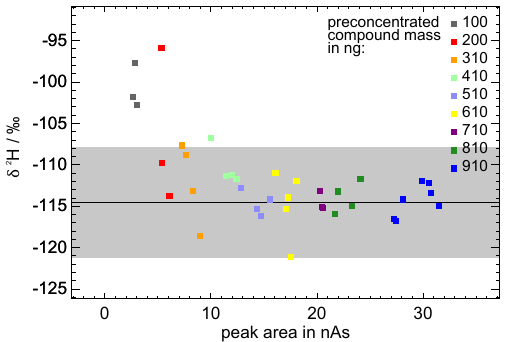
Figure 5. A step in δ 2 H values was apparent after 6 measurements, when the ceramic tube was conditioned for 5min, after 10 measure- ments, when conditioned for 10min, and after 20 measurements, when conditioned for 20min. The measurements after conditioning for 5min are represented by red dots, measurements after condition- ing for 10min by blue triangles and measurements after 20min by green squares. The grey bar shows the value obtained by elemental analysis (EA) (Agroisolab), where the thickness of the bar is equal to the uncertainty given by Agroisolab. This effect is observed for all measured substances and shown here for n -octane as an